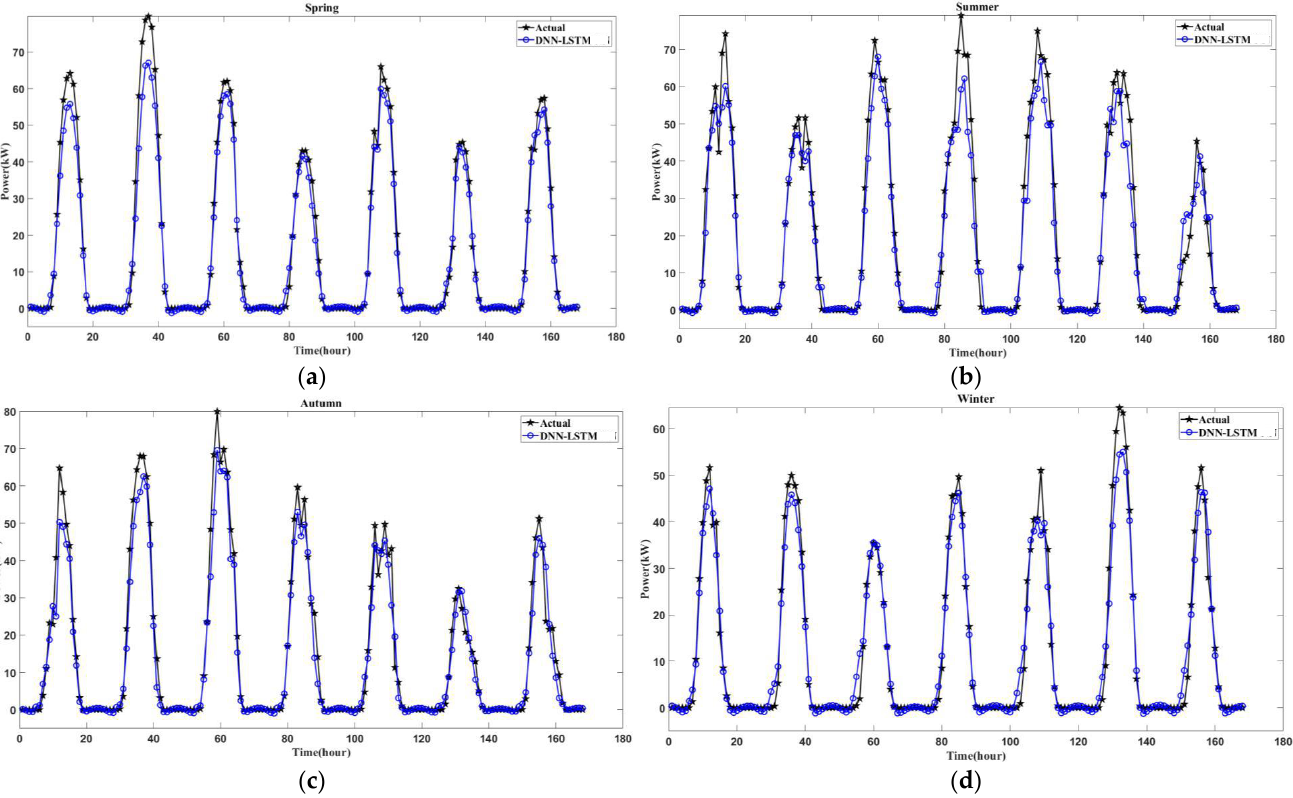
Figure 8. Hourly power generation forecasting results by DNN-LSTM during one week for solar power plant C: ( a ) spring; ( b ) summer; ( c ) autumn; ( d ) winter. Table 7. Comparisons of performance indicators of five forecasting models for solar power plant